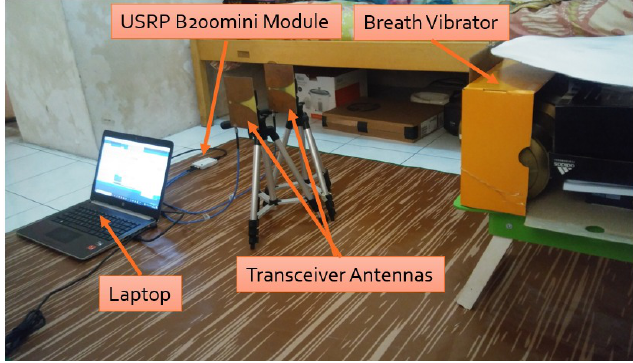
Figure 8. Experiment 1